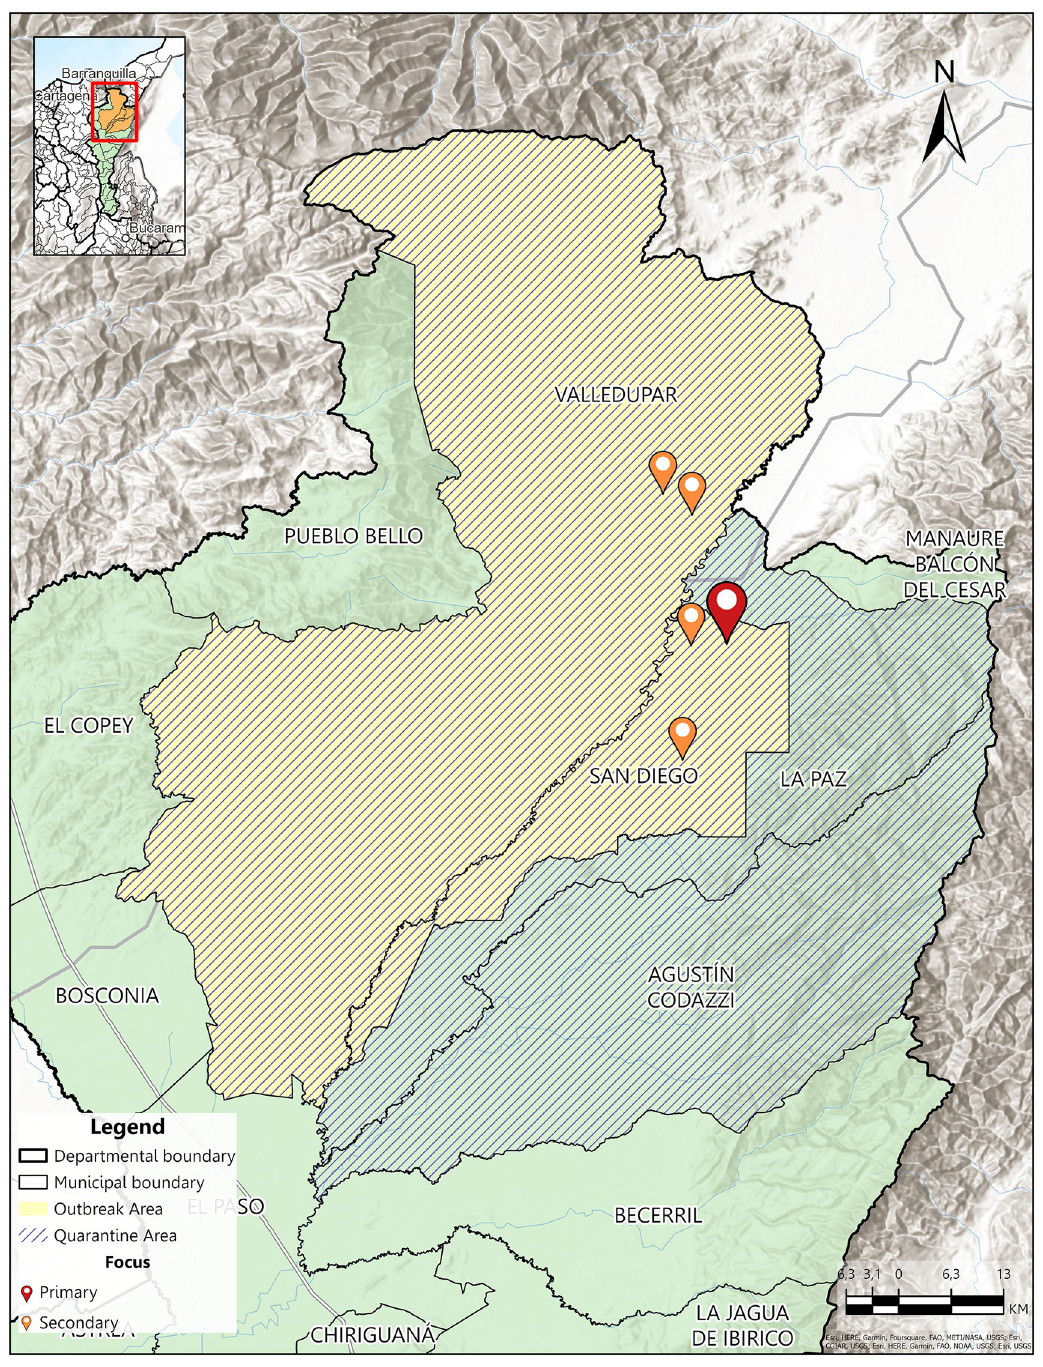
Fig 2. Municipalities affected by FMD in the Cesar (Colombia) department in 2018. Primary and secondary foci are marked as red and orange points, respectively. Quarantine (green) and outbreak (yellow) areas are also